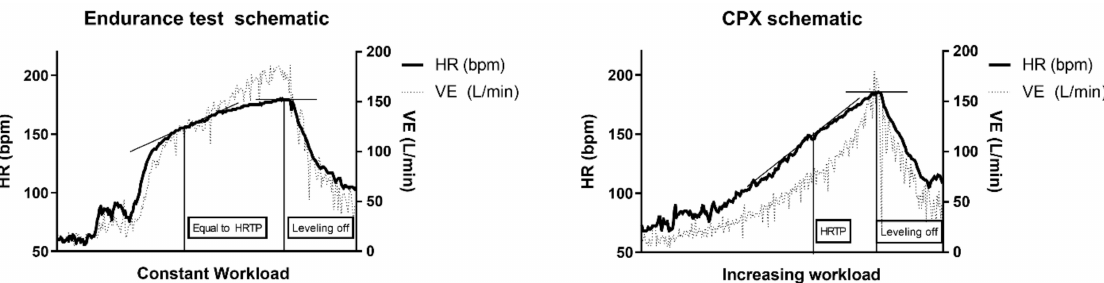
Figure 3. Schematic of the endurance exercise test at 120% VT 2 measured via 12-lead ECG and spirometry in comparison to the CPX test. VE: ventilation; HRTP: heart rate turn point; HR: heart